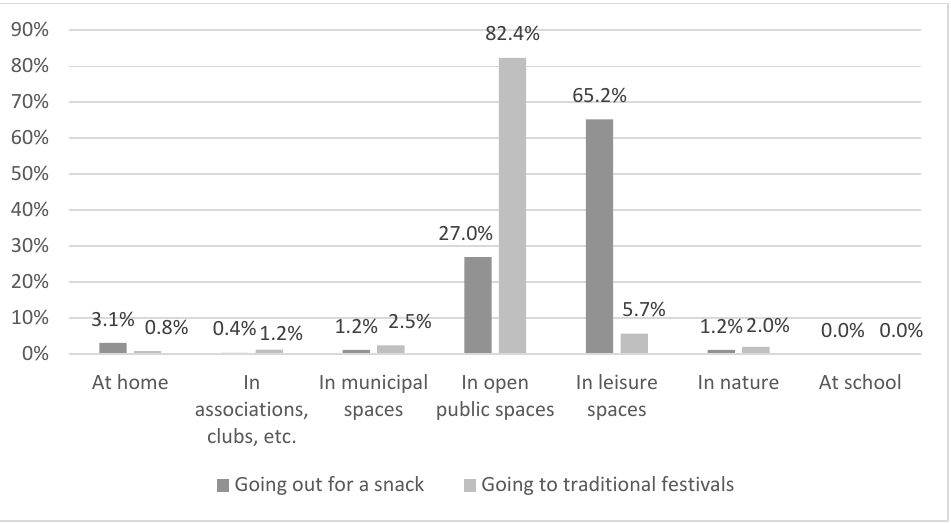
Figure 7. Places to practice festive leisure activities.